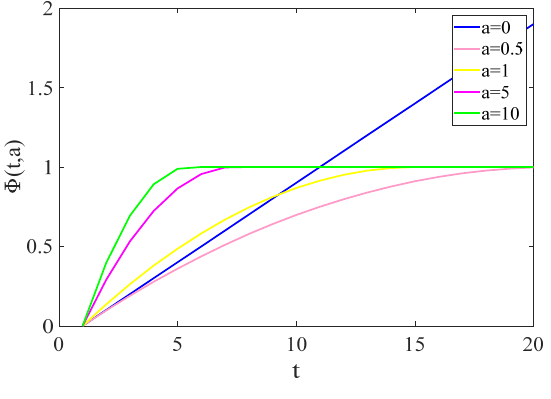
Figure 4. The curve of φ ( t , a ) .